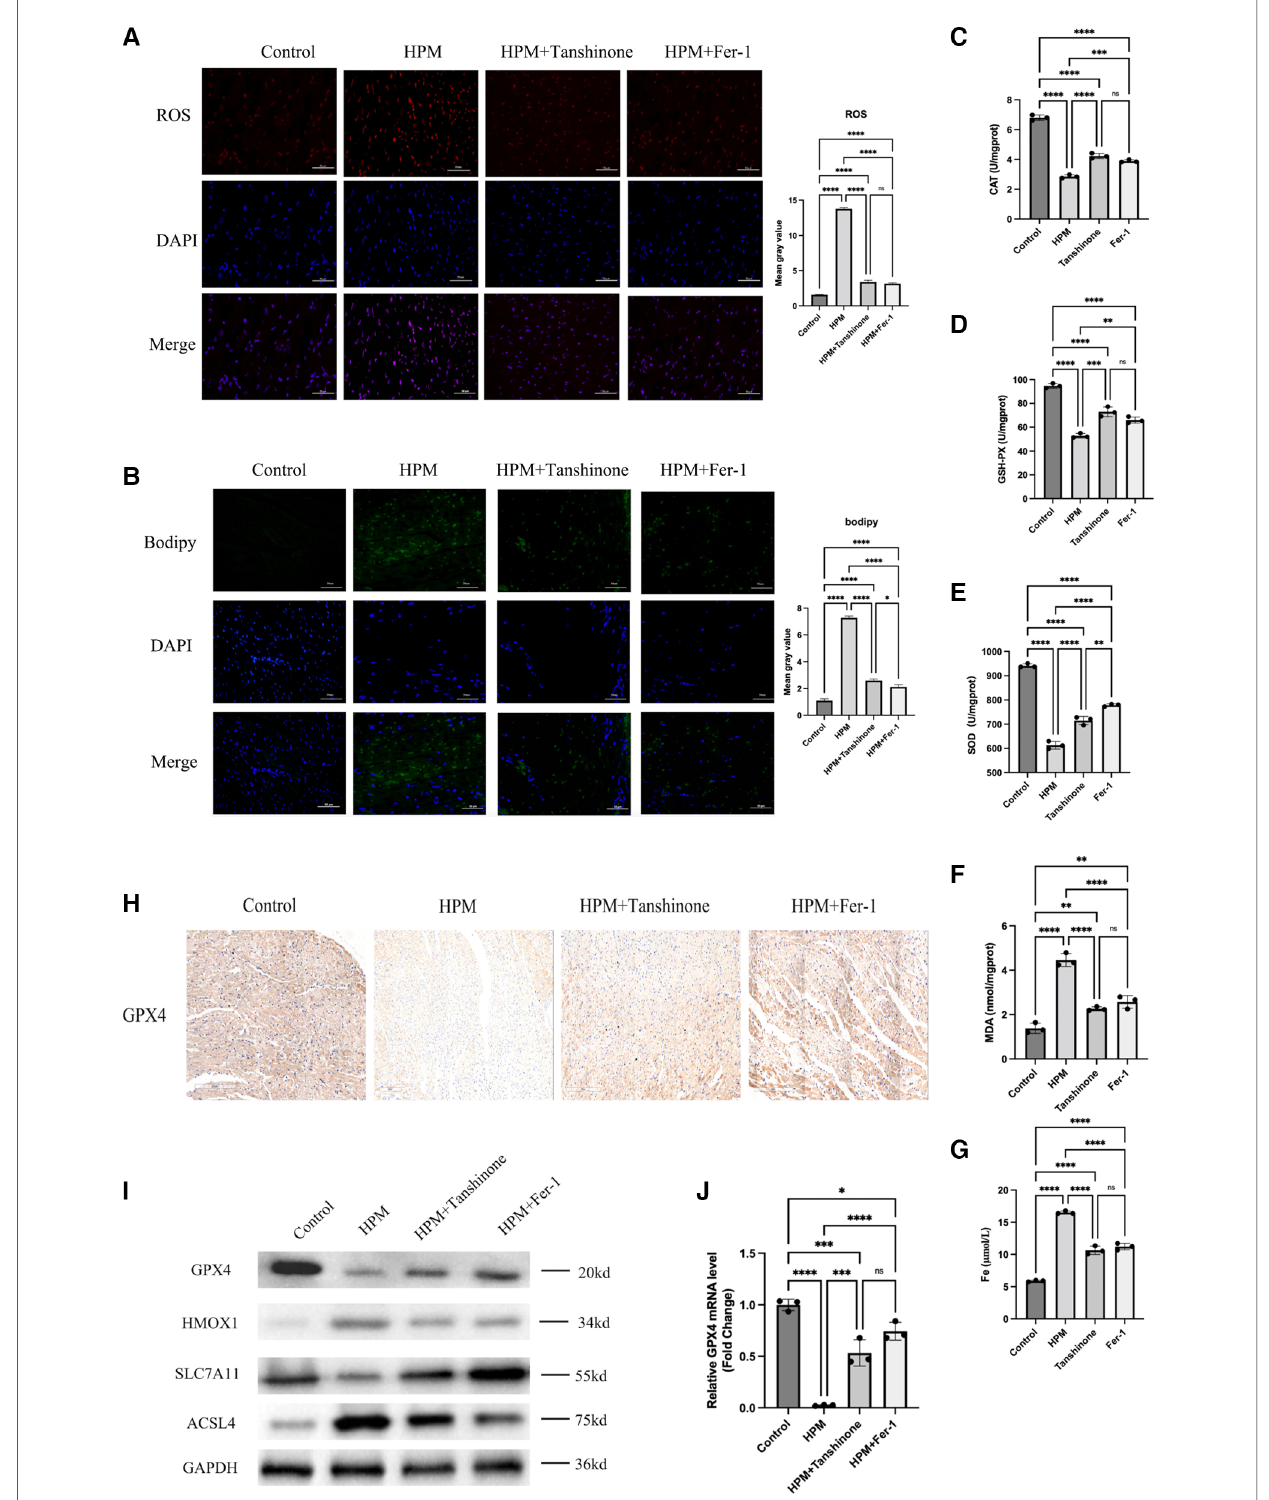
FIGURE 5 Tanshinone and Fer-1 inhibit ferroptosis in myocardial tissue of mice ( n =6). ( A,B ) Immuno fl uorescence technique staining of ROS, bodipy and DAPI in control, HPM, HPM+Tanshinone and HPM+Fer-1myocardial section were conducted. Scale bar: 50 μ m. ( C – F ) Elisa kit detect MAD, CAT, SOD and GSH of myocardial redox status in control and treatment group mice. ( G ) Serum Fe concentration in mice. ****, P <0.0001;*** P <0.001;**, P <0.01; ns, not signi fi cantone-way ANOVA, post hoc comparisons, Tukey ’ s test. ( I ) Protein levels of GPX4, HMOX1, ACSL4, SLC7A11 from the myocardial tissue in HPM- mice and treatment mice were analyzed with Western blot. ( J ) qRT-PCR analysis of GPX4 mRNA level was done in the myocardial tissue. **, P<0.01, one- way